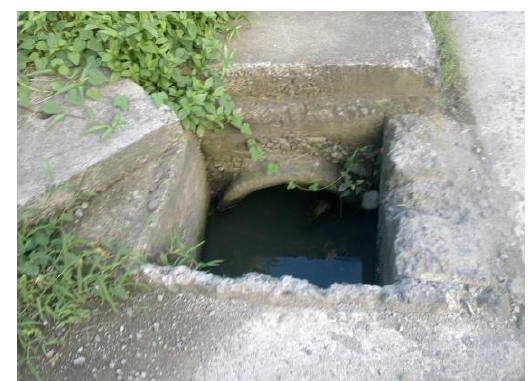
Figure 10. Part of a drainage system around the former pond area in Tacloban